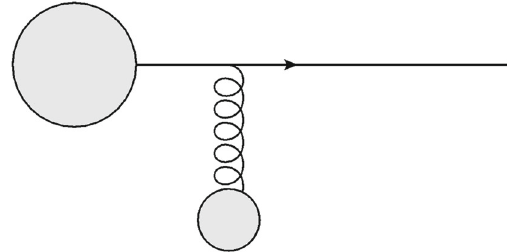
Fig. 4 The first order in opacity contribution to the amplitude for lead- ing order momentum broadening